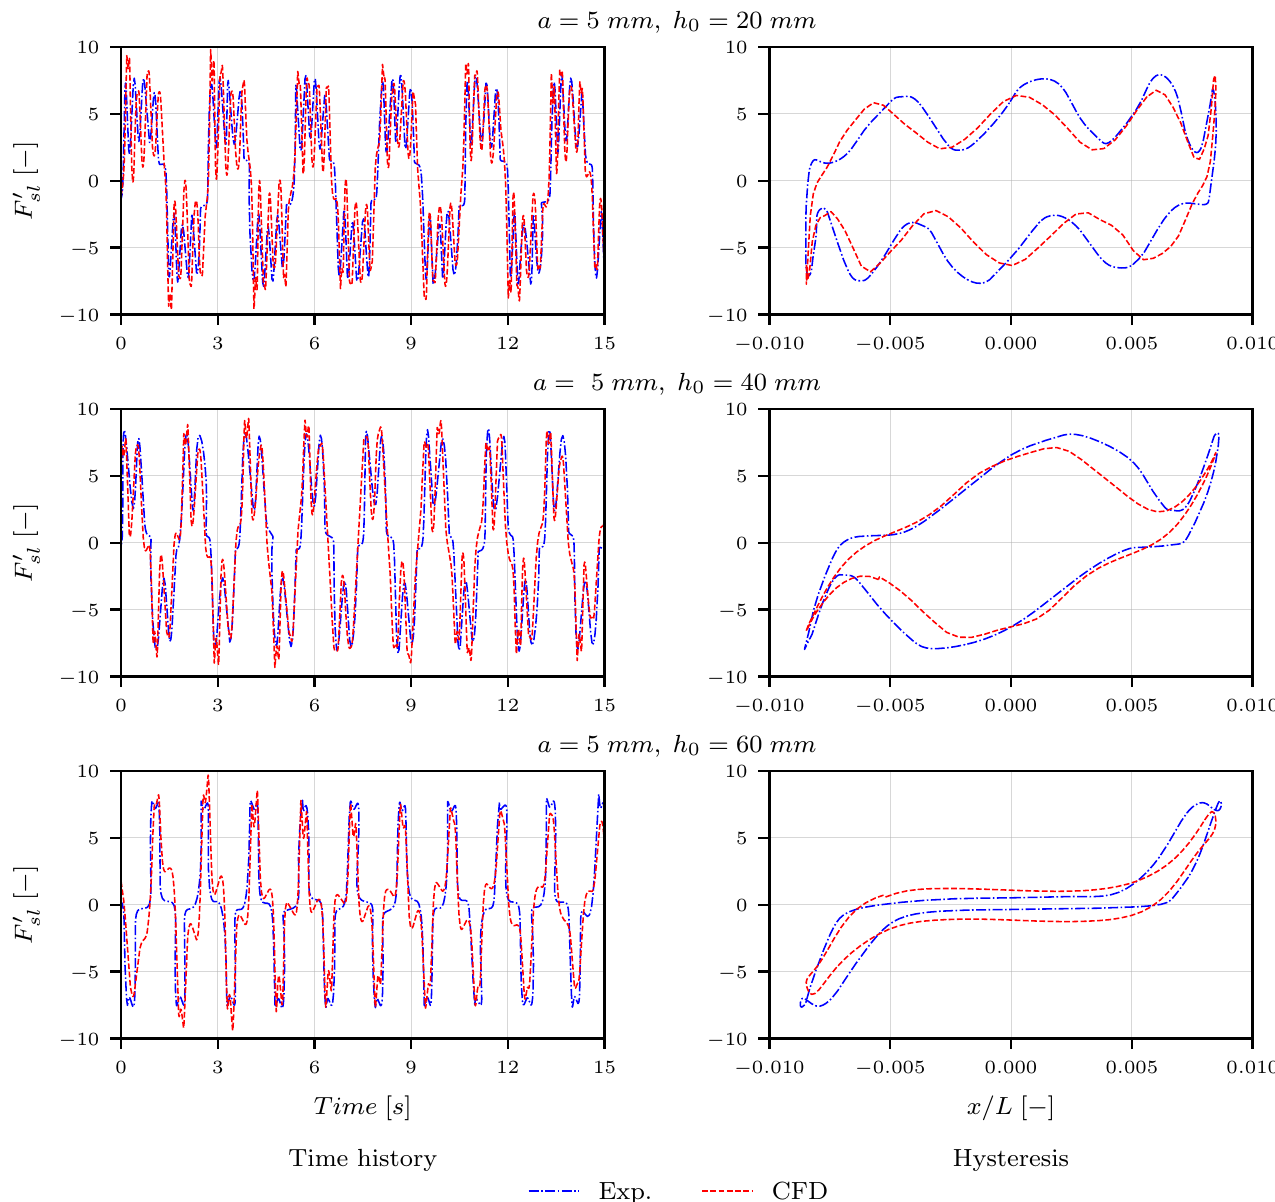
Figure 3. Validation results for varying the water